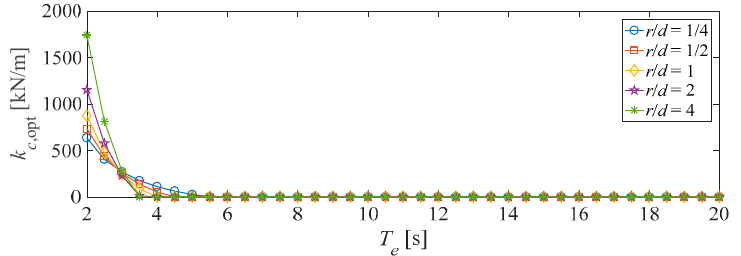
Figure 11. Optimal external stiffness k c ,opt of the WEC as a function of the energy period T e at different radiu- todraft ratios.